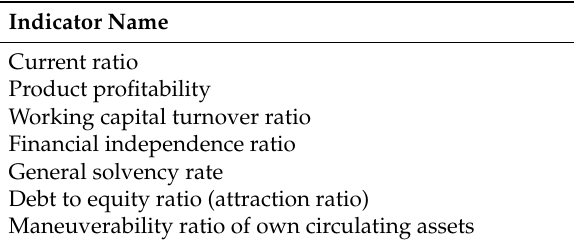
Table 3. Indicators of the financial statement of an